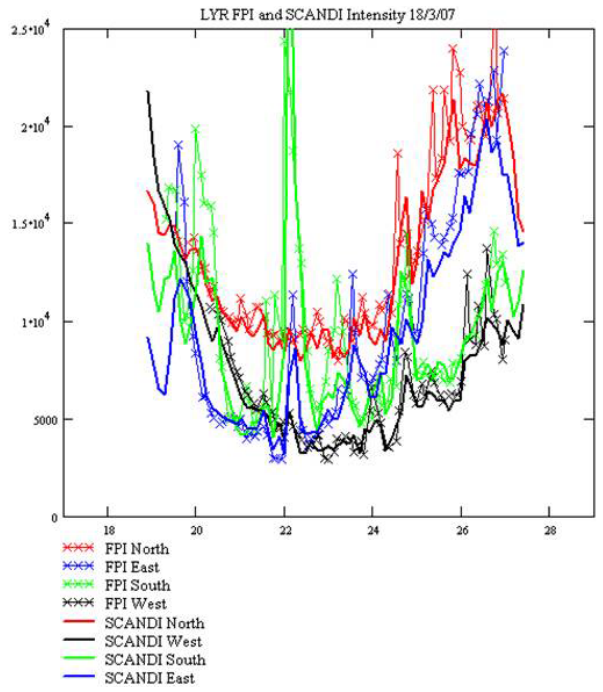
Fig. 15. SCANDI and FPI observations showing meso-scale struc- ture in 630nm intensity on 18 March 2007 over a field-of-view with radius ∼